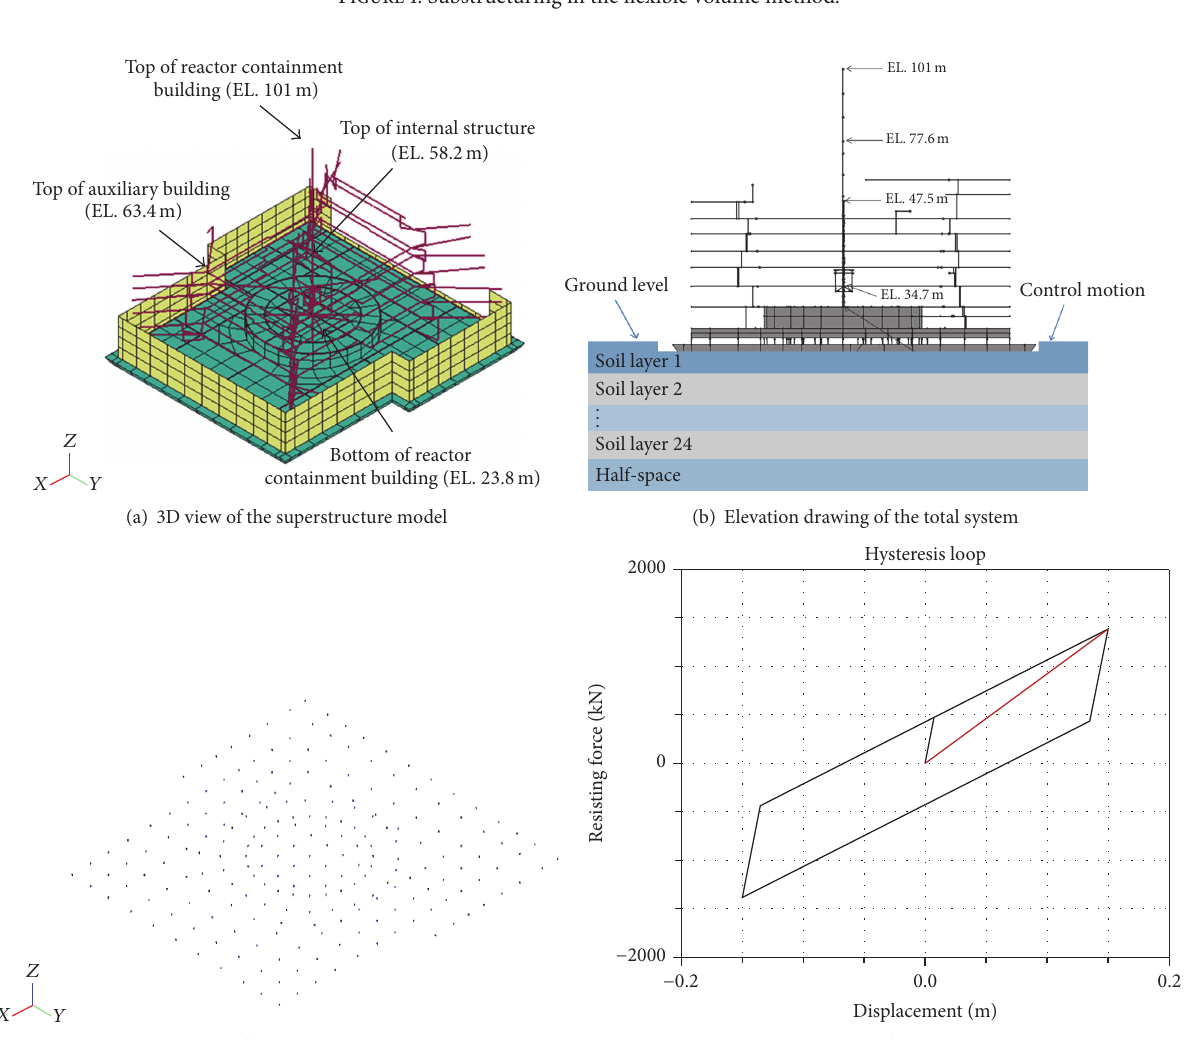
Figure 2: SASSI Model (EL: elevation